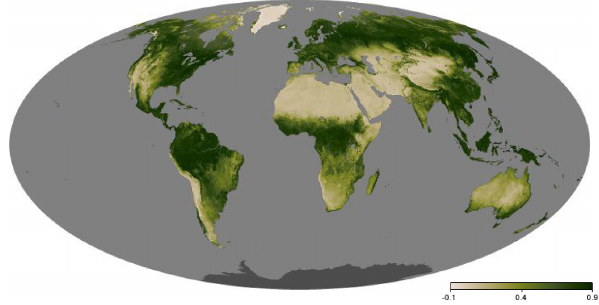
Figure 9. MODIS normalised difference vegetation index (NDVI) for July 2014. Source: https://earthobservatory.nasa. gov/global-maps/TRMM_3B43M/MOD_NDVI_M (last access: 2 April